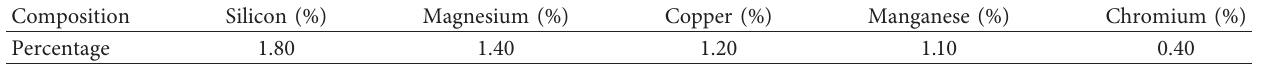
Table 1: Chemical opus of aluminium alloy